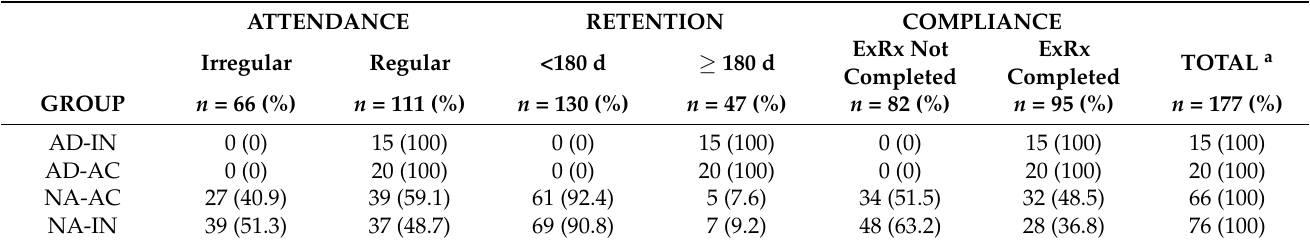
Table 6. Distribution of CAMINEM adherence by intervention